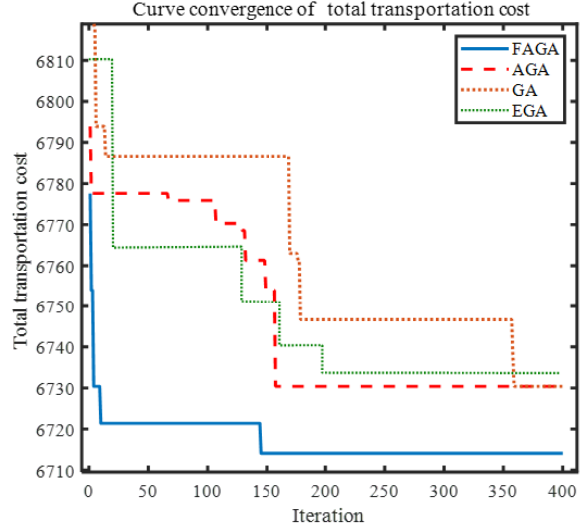
Figure 23. The fitness iterative curve of GA, AGA, EGA, and FAGA.